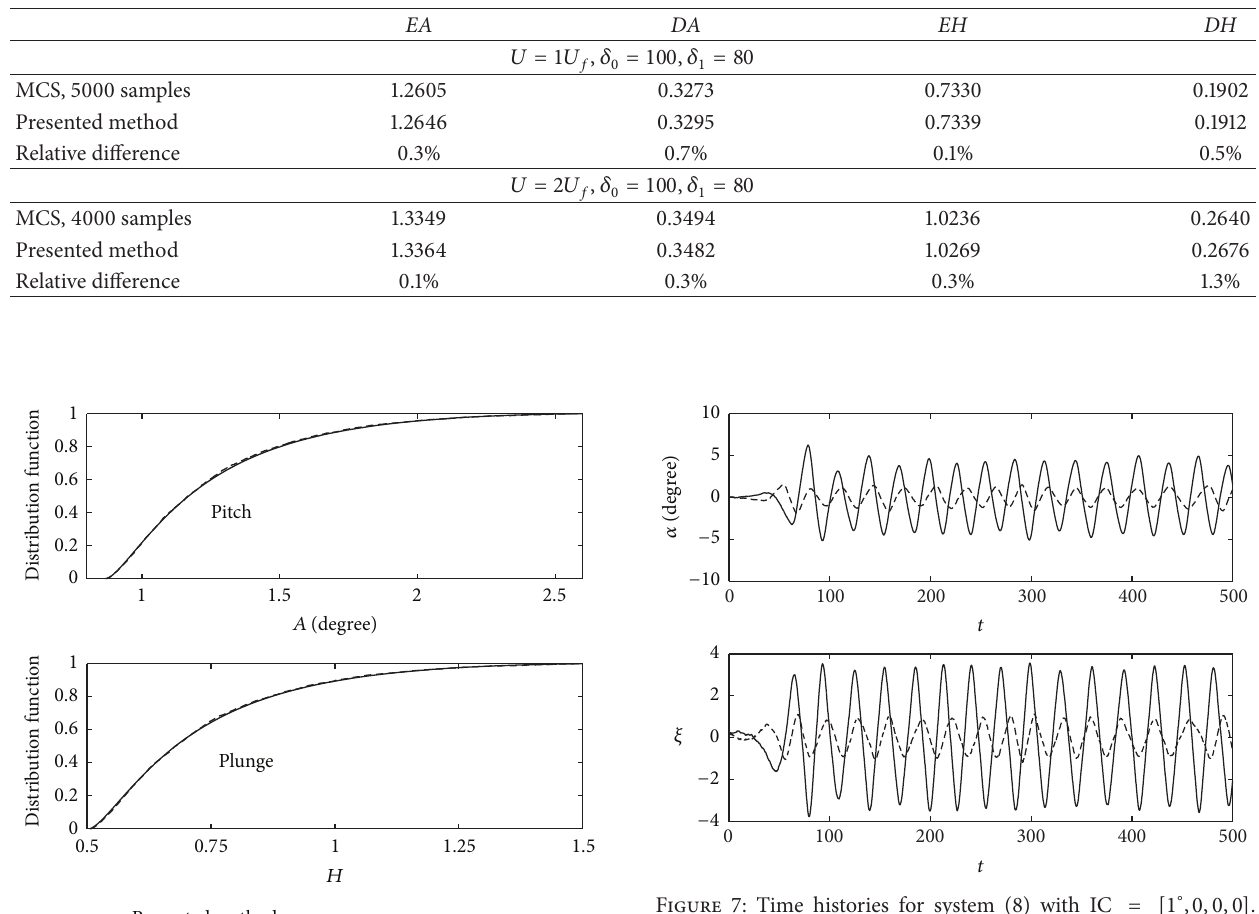
Table 6: Comparisons of the mean and standard derivation by the presented method with those by MCS.